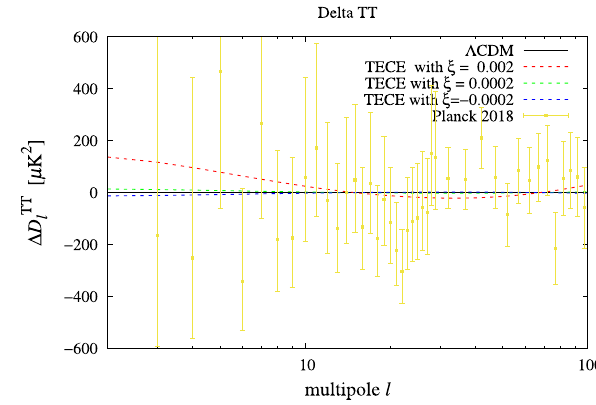
Fig. 7 Legend is the same as Fig. 2 but in the TECE model with a set of ξ